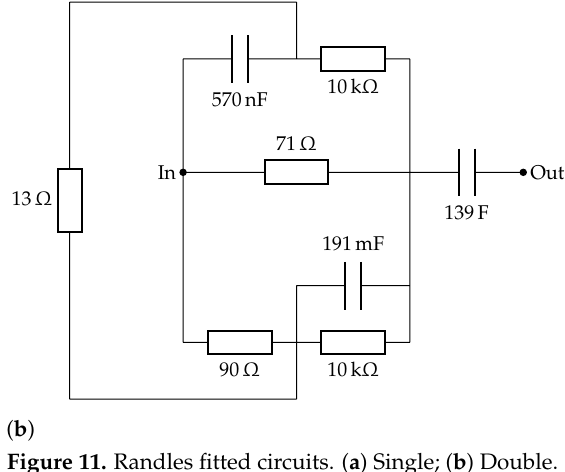
Figure 11. Randles fitted circuits. ( a ) Single; ( b ) Double.